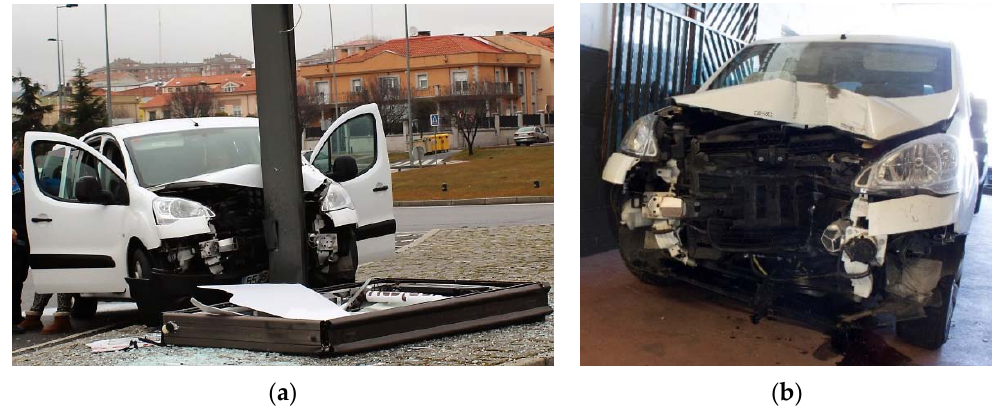
Figure 5. Traffic accident evaluated: ( a ) results after the impact of the van against the fixed element, and ( b ) detailed view of the car’s frontal after the accident. Table 1. Technical characteristics of the vehicle involved in the traffic accident.